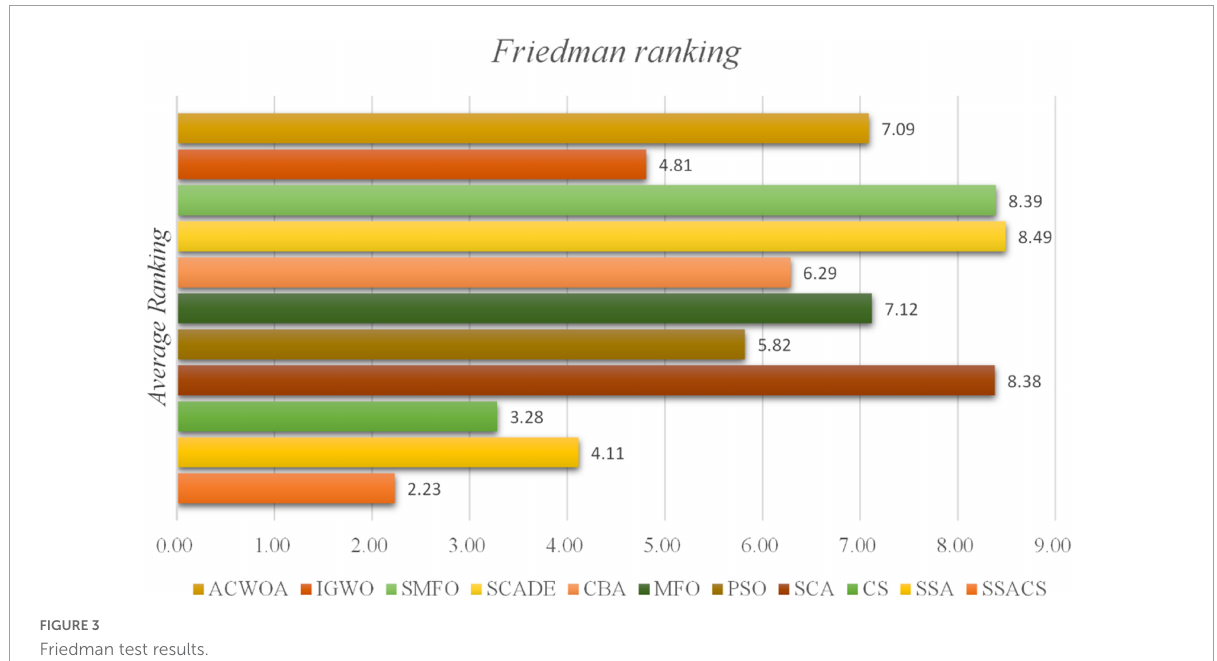
FIGURE3 Friedman test